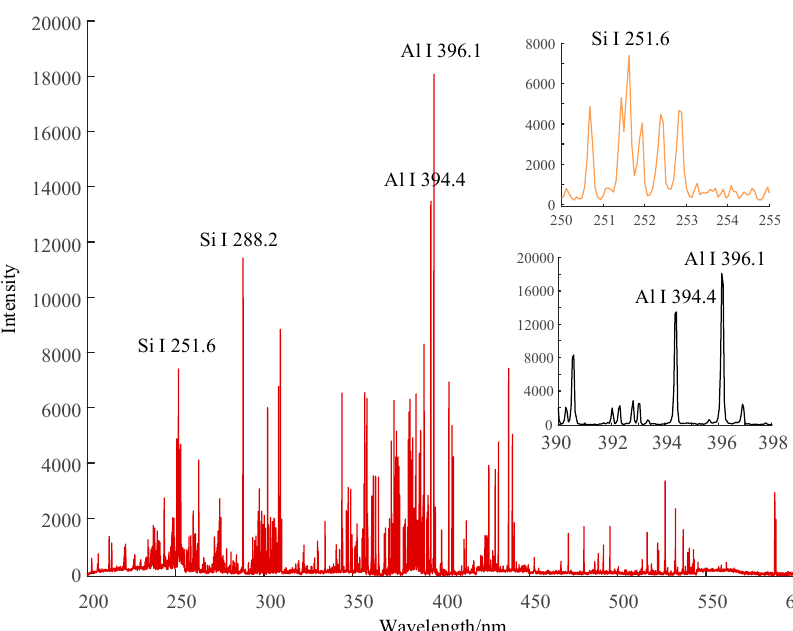
Figure 5. Emission spectrum of the new HTV silicone rubber for the first shot, while the mass fraction of its ATH and silica filler is 1.0 and 0.3, respectively.